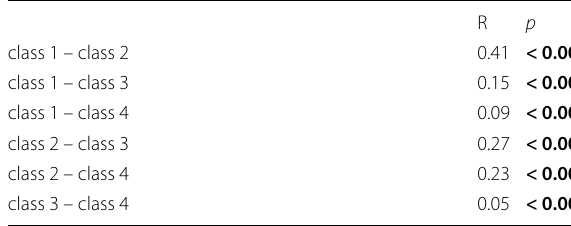
Table 4 Comparisons of plant species composition between the forest age classes (class 1: 5–10-year-old forest stands with mature forest patches, class 2: 40–45-year-old forests, class 3: 60–65-year- old forests, and class 4: more than 90-year-old forests) with one- way analysis of similarities (ANOSIM) in the dolines of the Mecsek